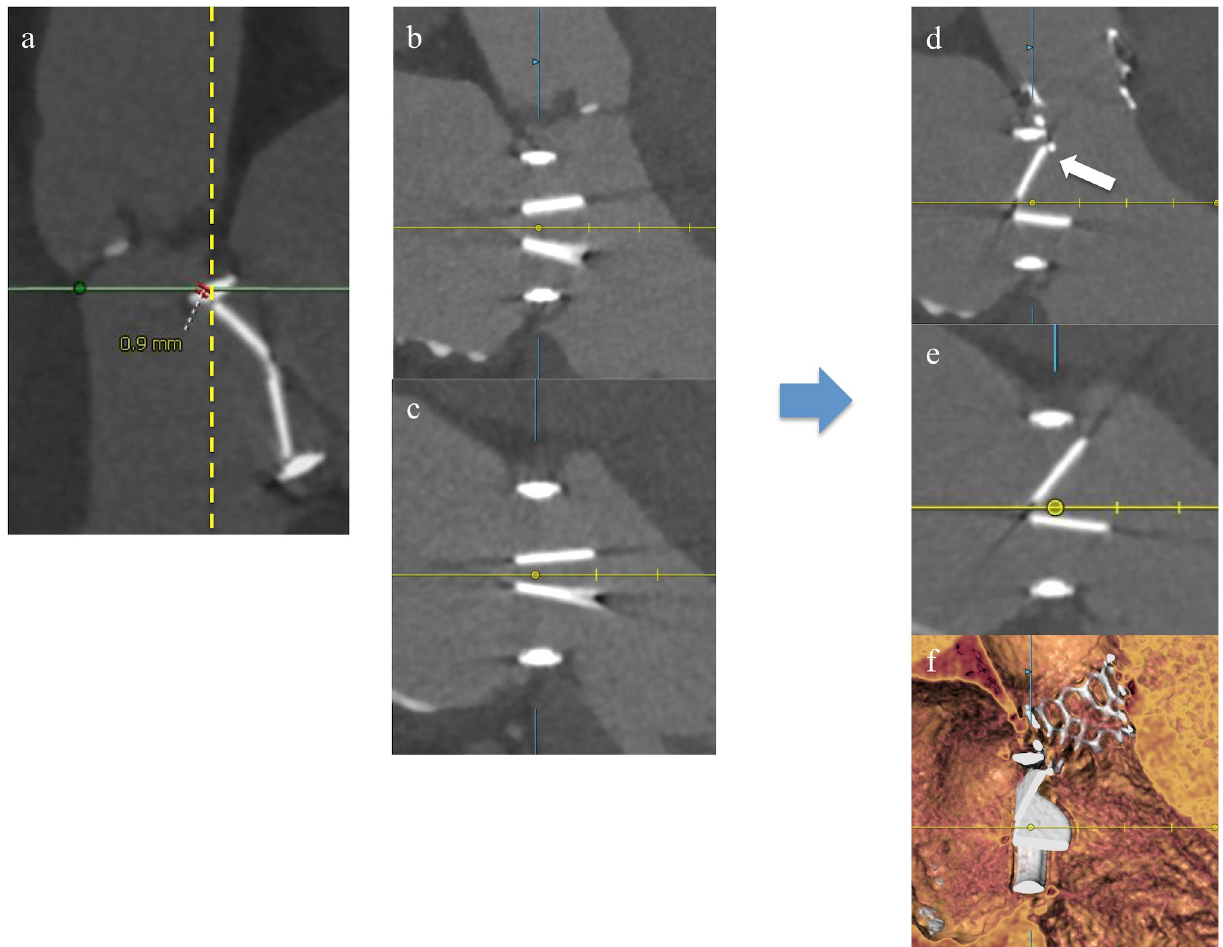
Fig 3. MDCT assessment of case #16. (a) Sagittal view of the aortic root (systolic-phase preprocedural MDCT). (b) Sagittal view of the mitral prosthesis (diastolic-phase preprocedural MDCT). (c) Perpendicular view of the mitral prosthesis leaflets (diastolic-phase preprocedural MDCT). (d) Sagittal view of the mitral prosthesis (diastolic-phase postprocedural MDCT). (e) Perpendicular view of the mitral prosthesis leaflets (diastolic-phase postprocedural MDCT). (f) Sagittal view of the mitral prosthesis (diastolic-phase postprocedural MDCT in the volume-rendering